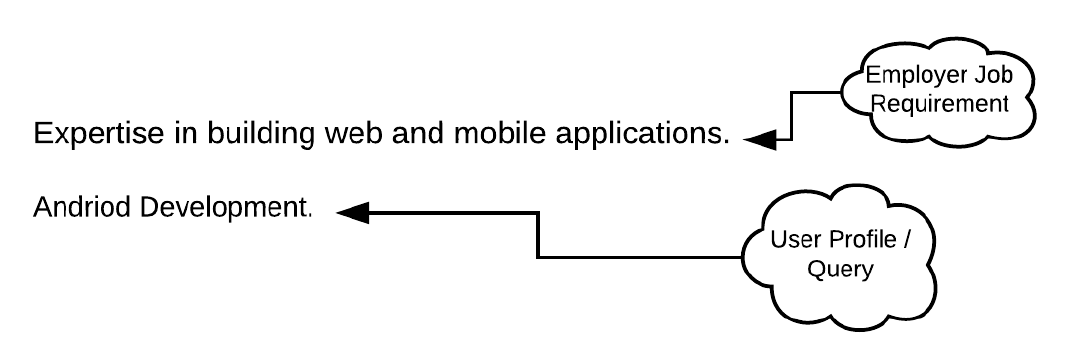
Figure 2. A sample semantic difference between a job description and a user